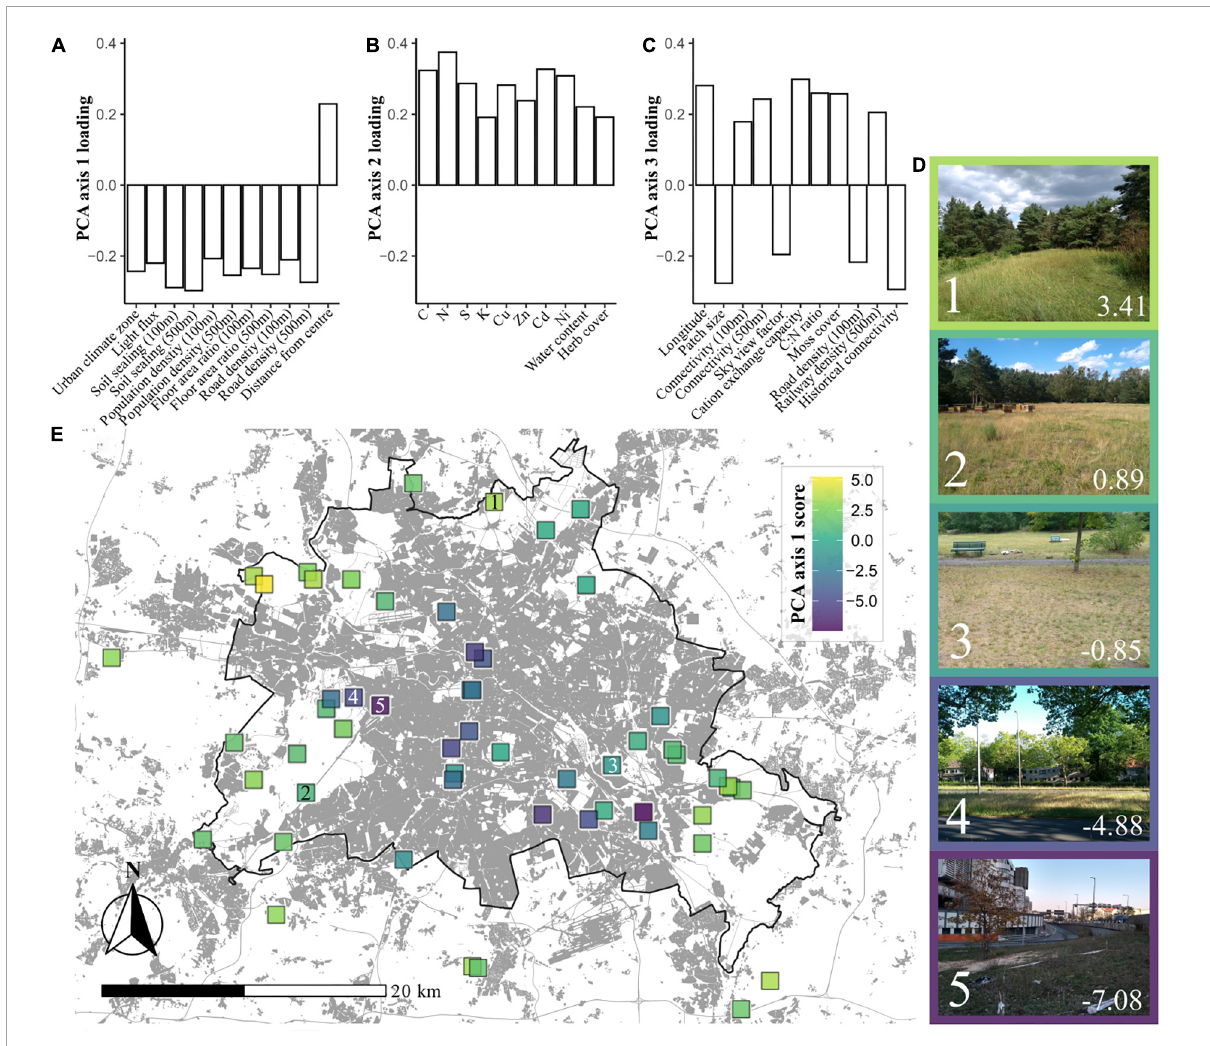
FIGURE1 Environmental gradients across grasslands in Berlin. (A) Environmental variable loadings within principal component analysis (PCA) axis 1 (21.2% of variance), which can be summarized as being representative of urbanity. (B) Variable loadings for PCA axis 2 (10.8%), which can be summarized as being representative of soil chemistry. (C) Variable loadings for PCA axis 3 (7.9%), which contains an amalgamation of variables, but with patch size, sky view factor, connectivity, and historical connectivity suggesting that this axis could be seen as something of a vignette of physical site characteristics. (D) Examples of sites with differing PCA axis 1 scores, which are denoted in the bottom right hand corner of each image. Numbers in the bottom left hand corners denote locations on the map. (E) A map of Berlin with the locations of the sites included in this study. Each site is shaded by its PCA axis 1 score, representing urbanity. Darker coloration indicates more urban sites. The black line represents the border between Berlin and its neighboring federal state, Brandenburg. Areas shaded gray represent built-on land, originally plotted by Anne Hiller (Technisches Universität Berlin), using data from the Landesamt für Umwelt Brandenburg (2009) and Senate Department for Urban Development and Housing